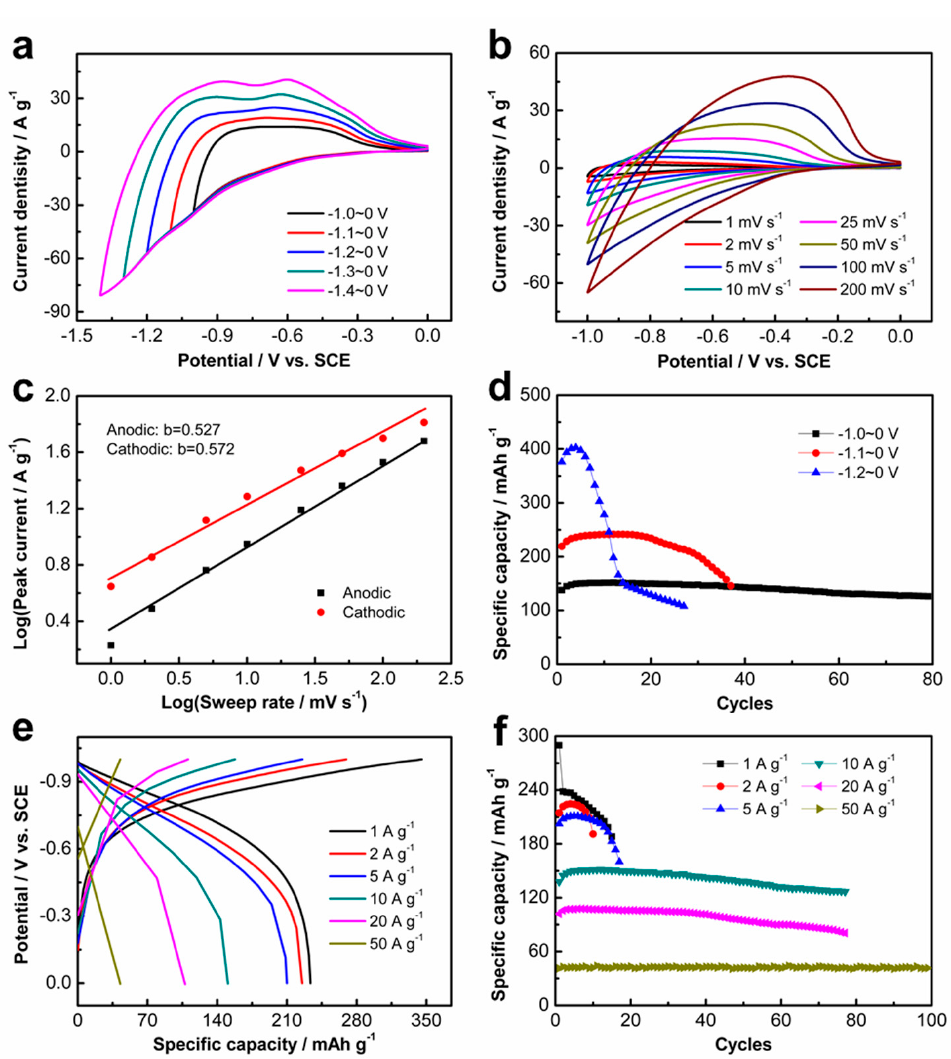
Figure 2. Electrochemical performance of K 2 Ti 8 O 17 electrode in the AlCl 3 aqueous solution: ( a ) CV curves at different potentials with sweep rate of 25 mV s − 1 . ( b ) CV curves with different scan rates at the potential range of − 1~0 V VS. SCE . ( c ) Corresponding dependency of b-value for redox peak currents on the logarithm of the sweep rates. ( d ) Cycling performance in areal specific capacities by GCD within different potential ranges at current density of 10 A g − 1 . ( e ) GCD curves with different current densities in the potential range of − 1~0 V VS. SCE . ( f ) Cycling performance at different current densities in the potential range of − 1.0~0 V VS. SCE .